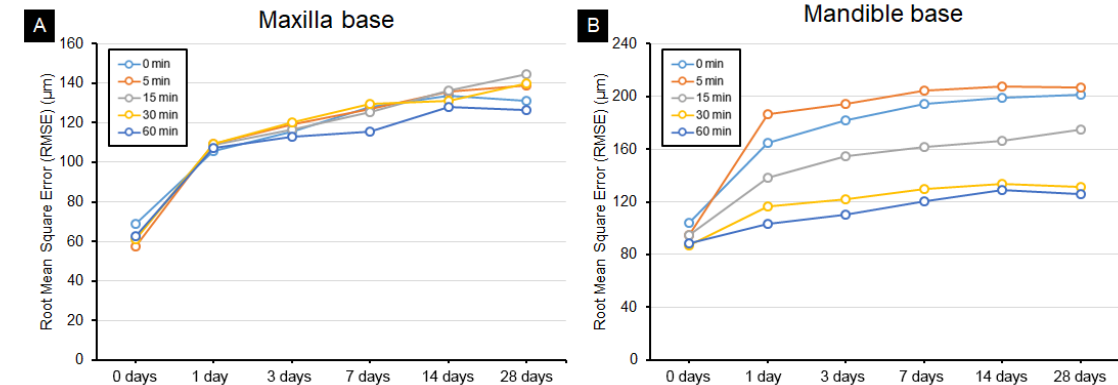
Figure 4. Trueness according to aging period after the printing process in the ( A ) maxilla base and ( B ) mandible base. The three-way ANOVA indicated that dimensional stability was significantly affected by the postcuring time dimensional stability (F = 51.07, p < 0.001), the elapsed time after printing (F = 123.11, p < 0.001), and the arch position (F = 280.15, p < 0.001). The postcuring time and arch position also had a mutually significant effect (F = 43.40, p < 0.001), as did the elapsed time after printing and the postcuring time (F = 1.73, p = 0.027). How-